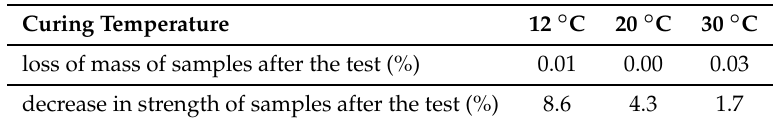
Table 8. Results of the tests of resisting of the concrete samples to cyclic freezing and thawing determined by the method according to PN-B-06250.